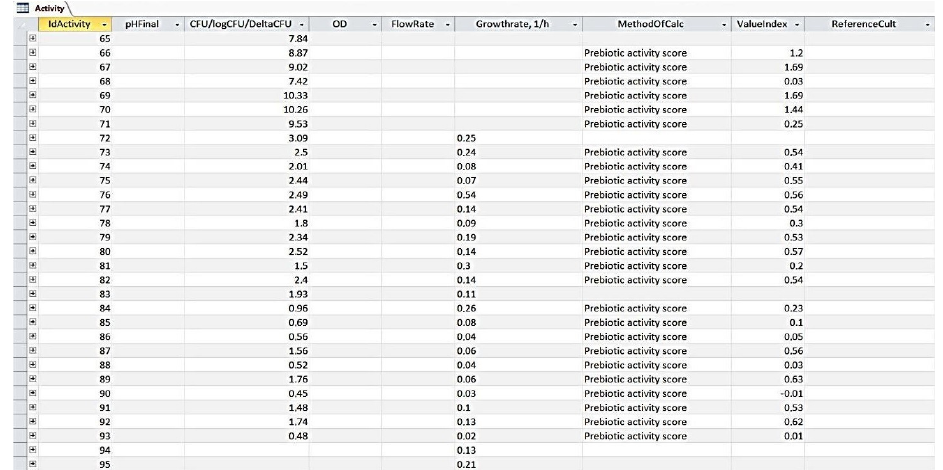
Table «Activity» containing information about the main physiological parameters of the micro-organisms growth on prebiotics (for example, final pH of fermentation, viable micro-organisms count, different methods for prebiotic activity definition and